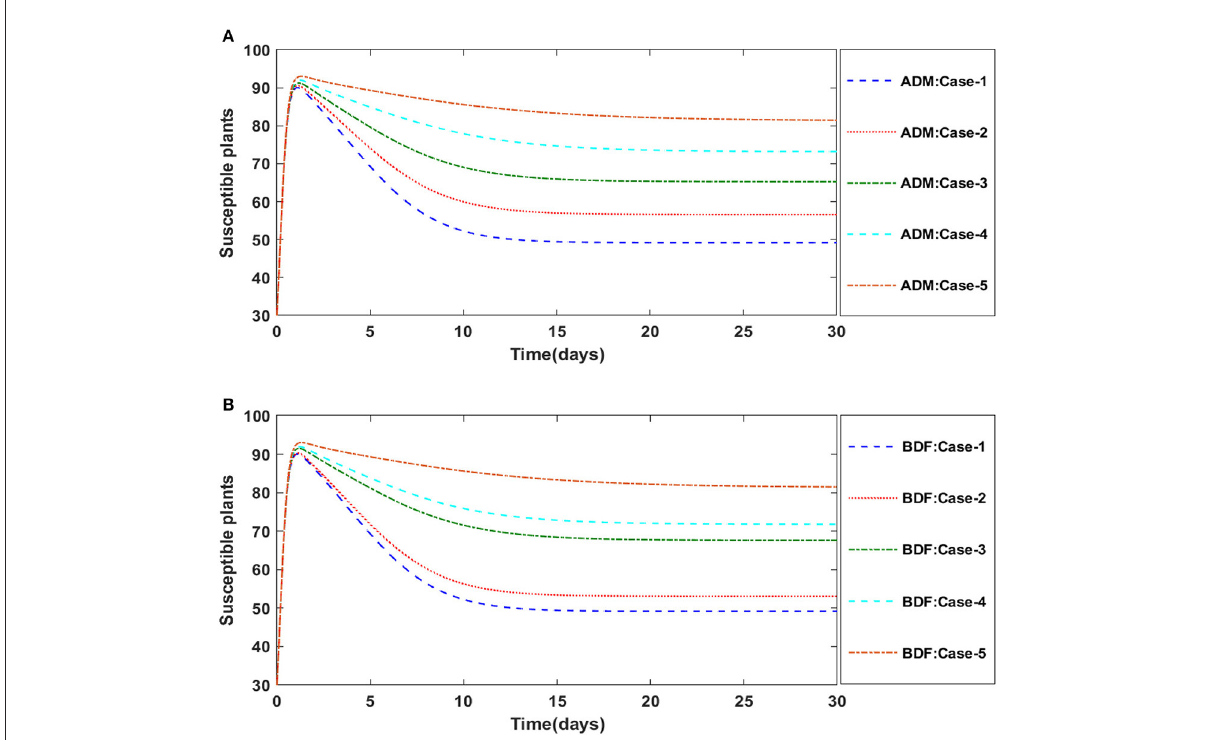
FIGURE14 (A) Dynamics of susceptible plants for the varition in c using ADM for model B. (B) Dynamics of susceptible plants for the varition in c using BDF for model B.